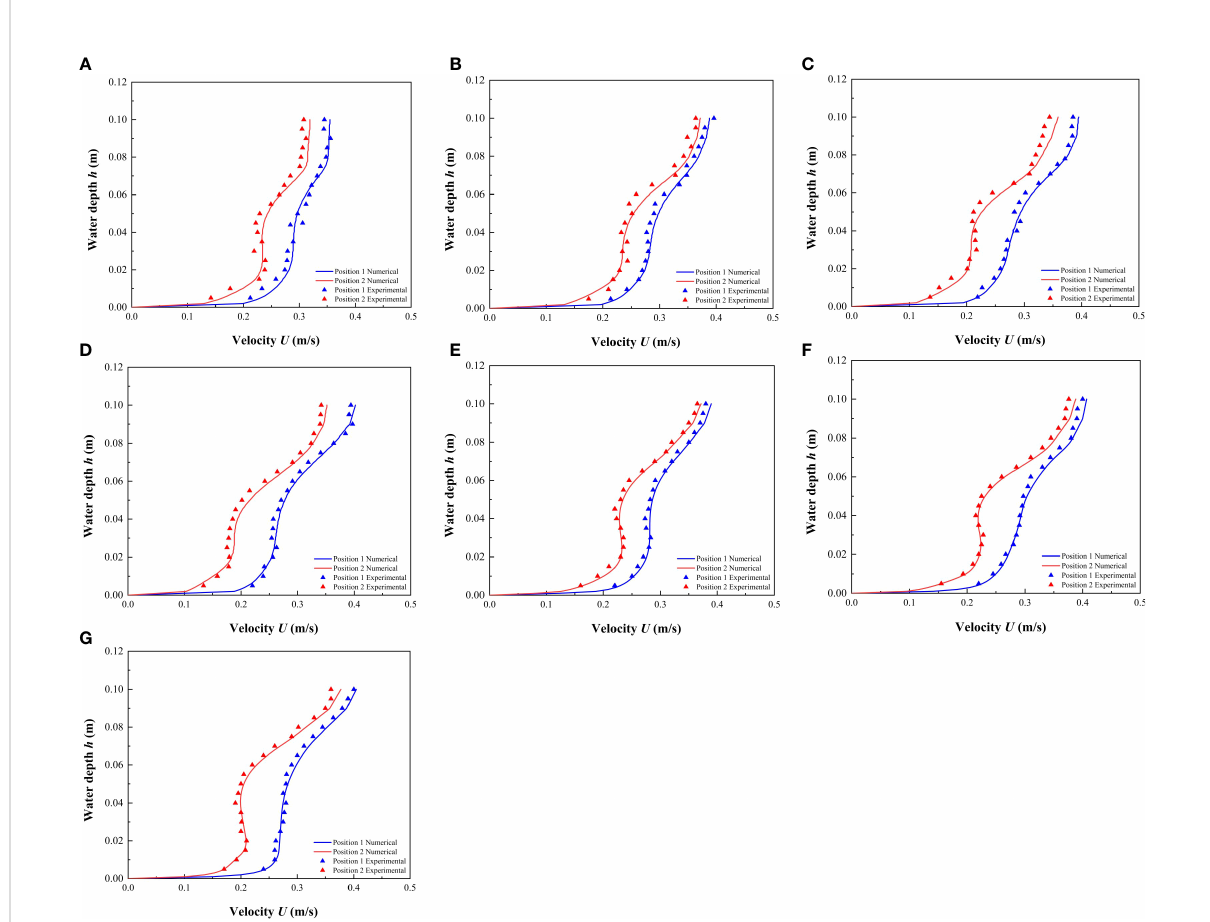
FIGURE 4 Comparison between the experimental results and the numerical results of the modeling method used in this study. (A) 0.012 m & 0.012 m, (B) 0.012 m & 0.015 m, (C) 0.012 m & 0.018 m, (D) 0.012 m & 0.021 m, (E) 0.009 m & 0.015 m, (F) 0.006 m & 0.018 m, (G) 0.003 m & 0.021